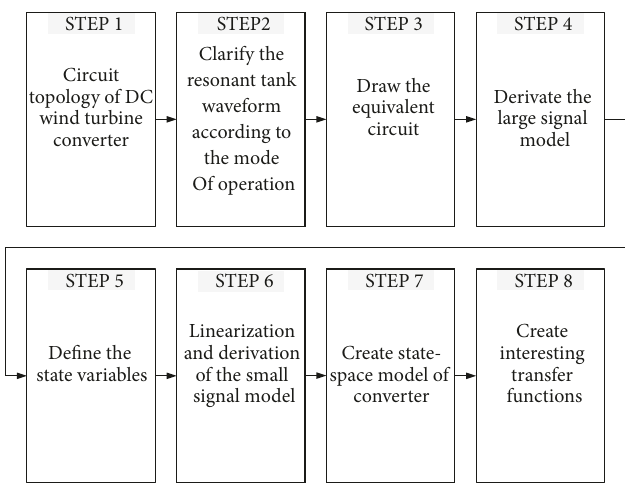
Figure 4: Flow chart of derivation of plant model of